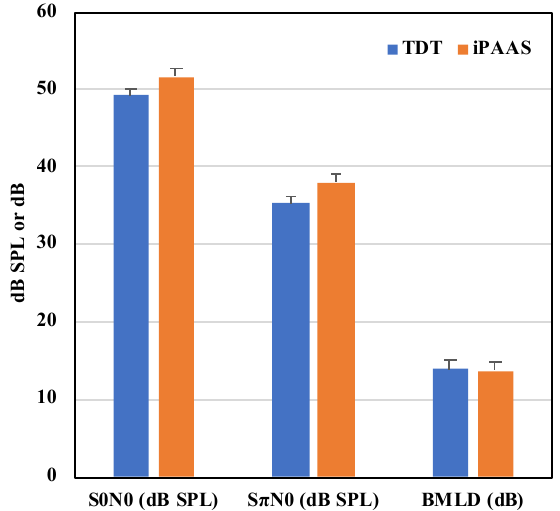
Figure 6. First two sets of bars show the 500 Hz pure tone detection levels in dB SPL in background noise of 70 dB SPL for the in-phase and out-of-phase conditions, respectively. The last set of bars show the BMLD values. The error bars represent the standard error of the mean.